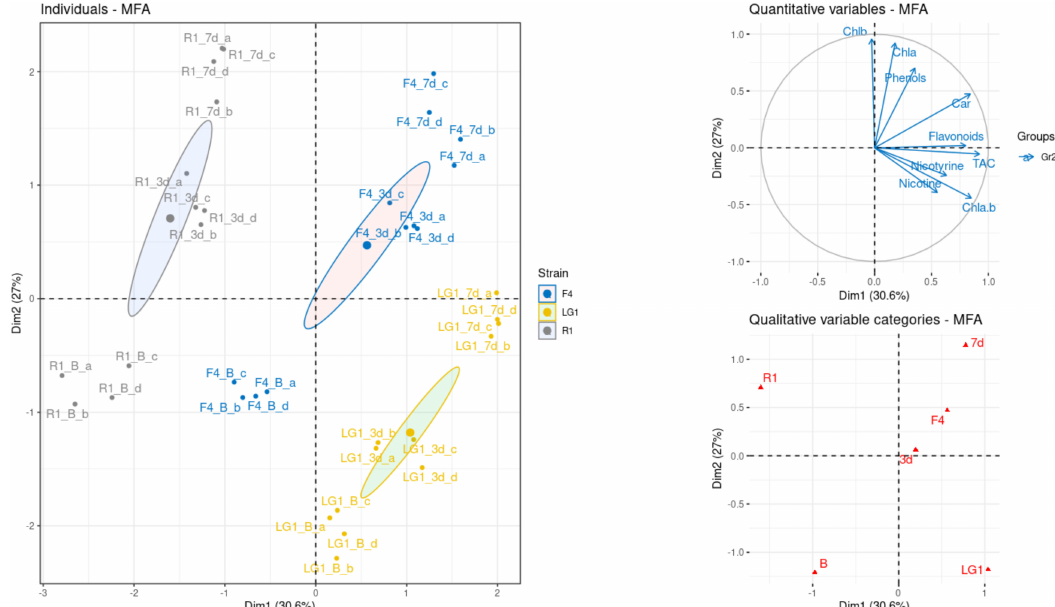
Figure 4. Multiple factor analysis (MFA) of physiological and analytical data on microalgal-based remediation of wastewater from a cigarette butt (CB) cleaning process, coupled with UV-B treatment. B: No UV-B irradiation; 3d: 3-day UV-B treatment; 7d: 7-day UV-B treatment; Chla.b: ratio of Chl a to Chl b ; a, b, c and d indicate